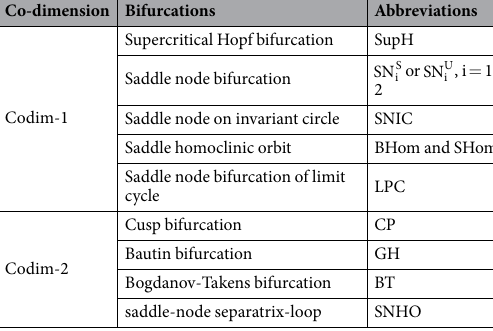
Table 1. Notations and abbreviations of the